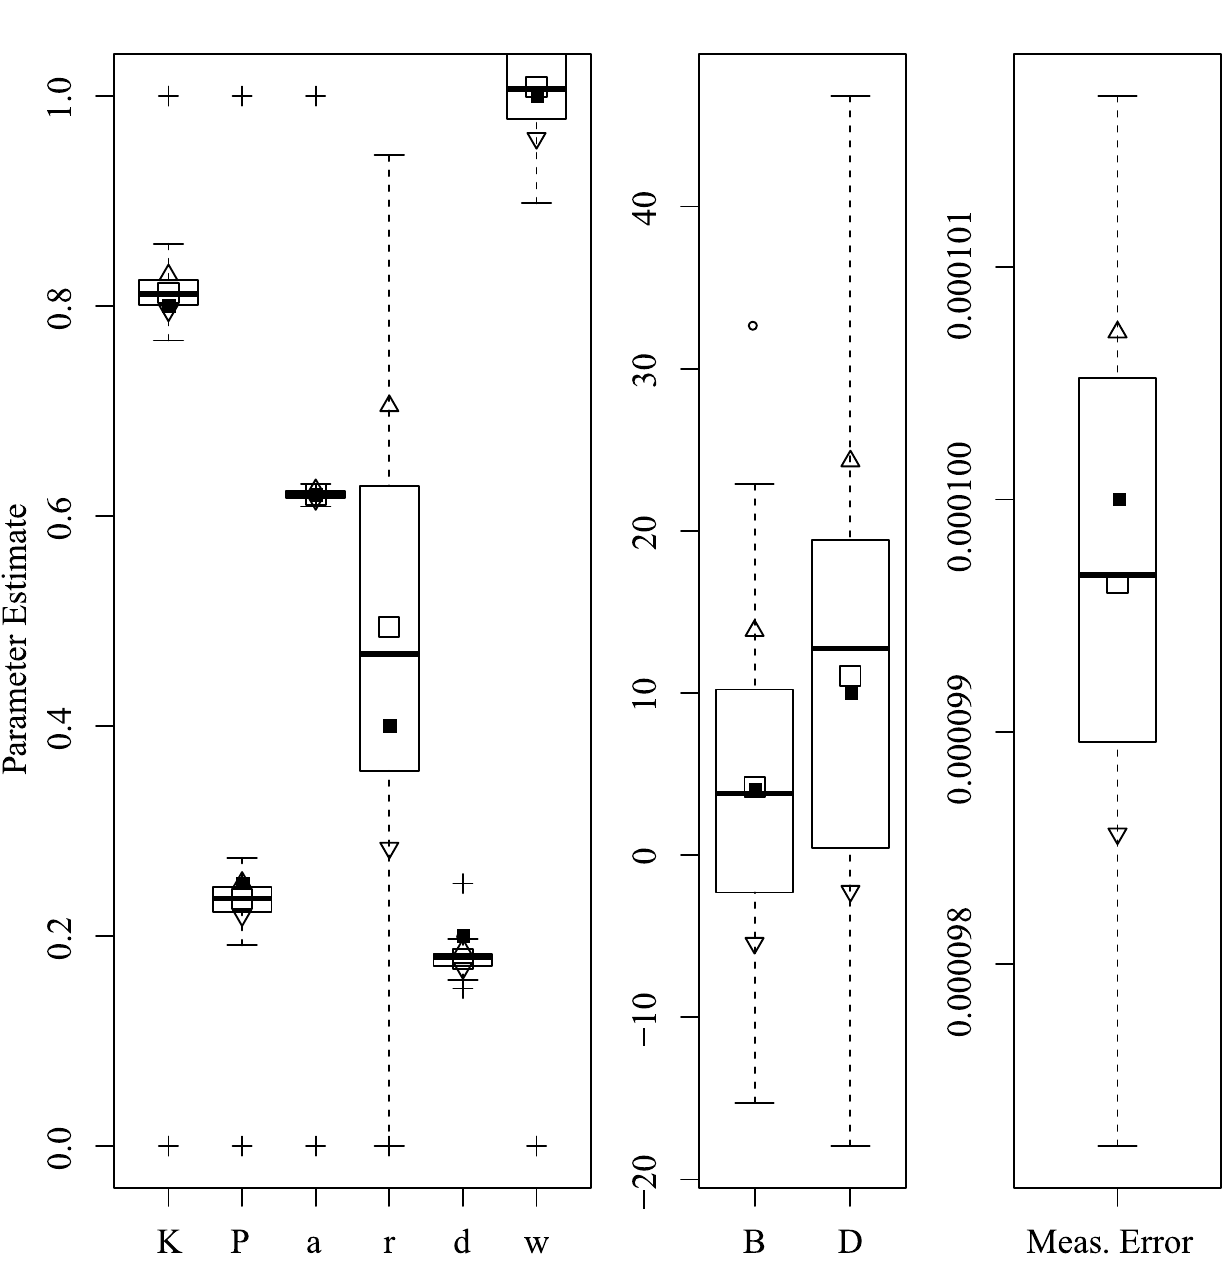
Fig 6. Parameter recovery results for the High Noise